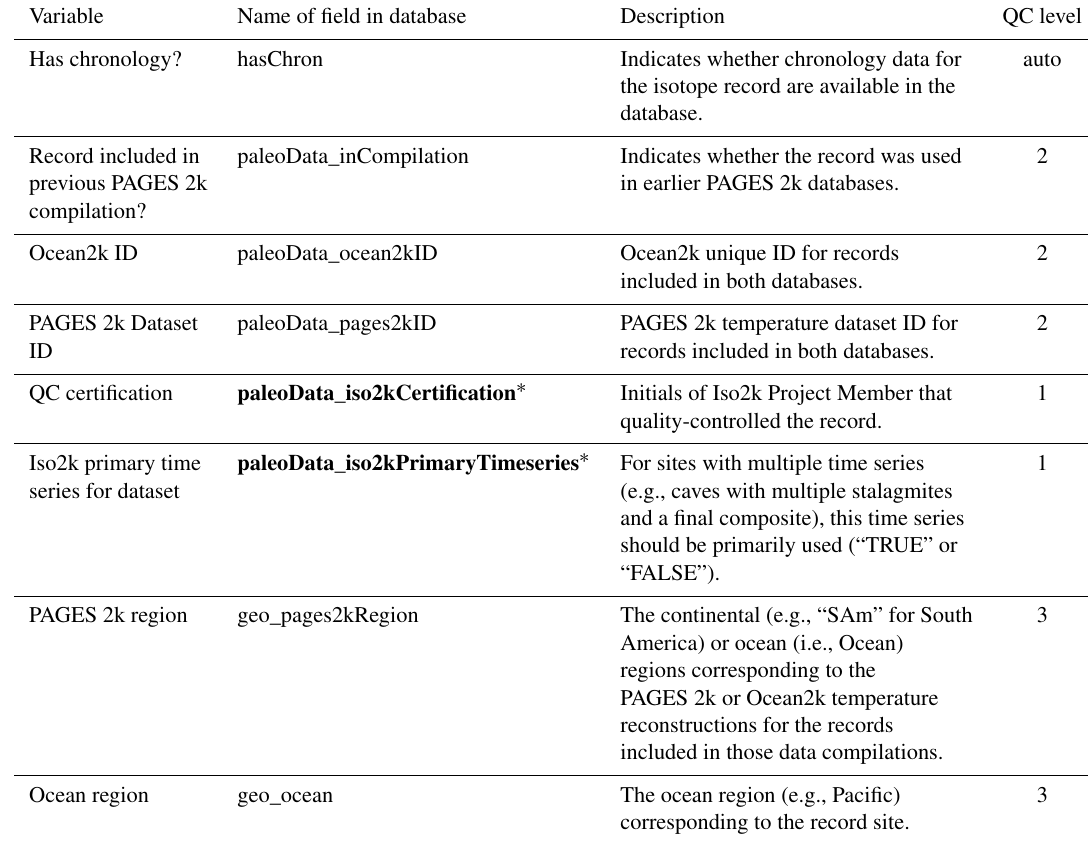
Table 6. Selected queryable metadata. ∗ Bold text indicates Level 1 or required fields in the